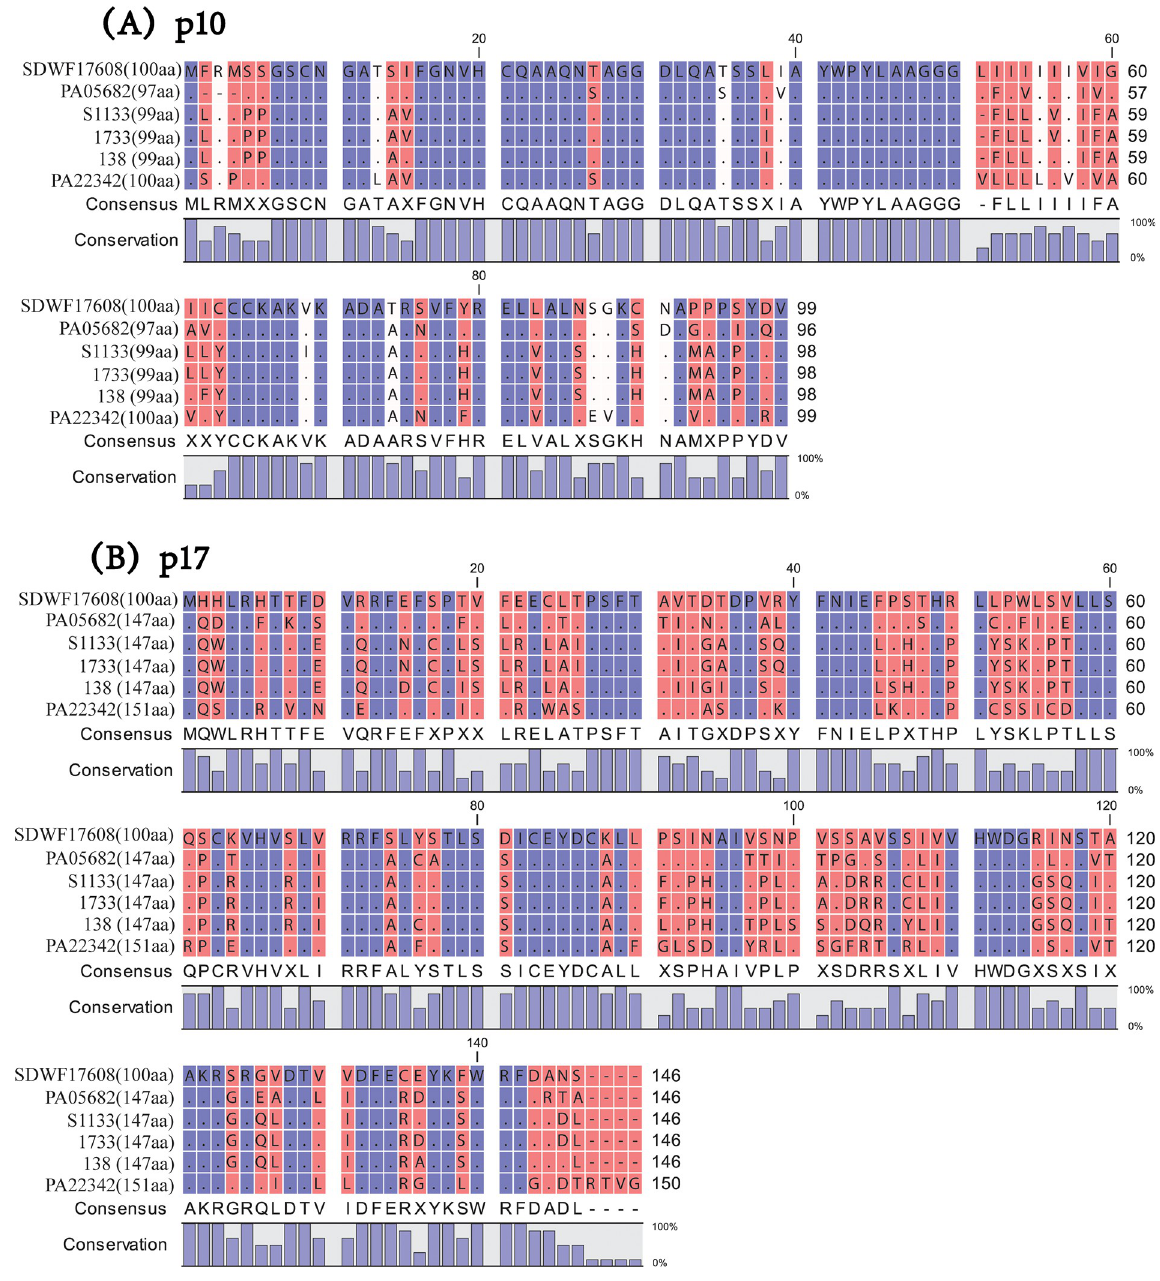
Fig 2. Amino acid alignment of p10 and p17 protein. A: The p10 protein of Reo/SDWF /Pheasant/17608/20 align with the homologous protein of Reo/PA/Broiler/05682/12 (or PA05682), S1133, 1733, 138 and Reo/PA/Turkey/22342/13 (or PA22342) strains; B: The p17 protein of Reo/SDWF /Pheasant/17608/20 align with the homologous protein of Reo/PA/Broiler/05682/12 (or PA05682), S1133, 1733, 138 and Reo/PA/ Turkey/22342/13 (or PA22342) strains.